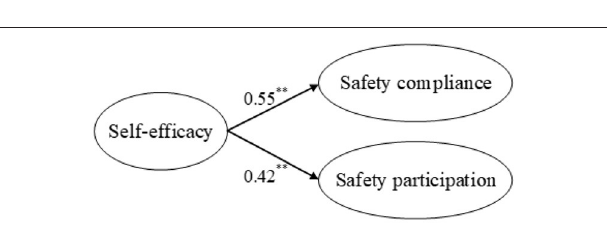
FIGURE 6 | Direct effects of self-efficacy on safety performance. ** p < 0.01.